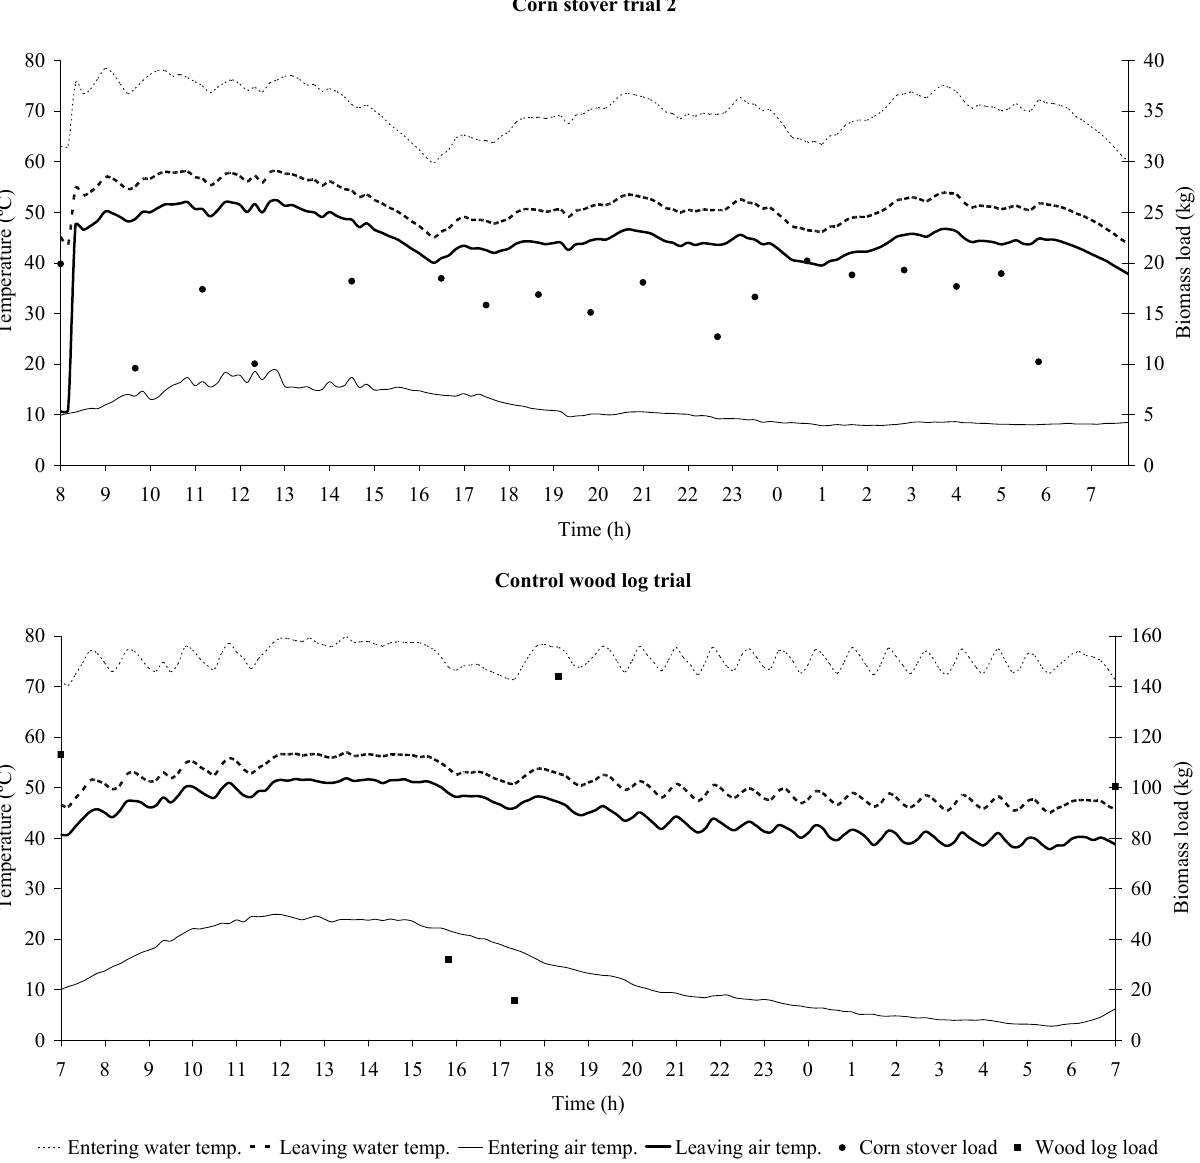
Figure 2. Discrete biomass loads and temperatures of water and air entering and exiting the heat exchanger for corn stover combustion trial 2 and control (wood combustion trial). Corn stover trial